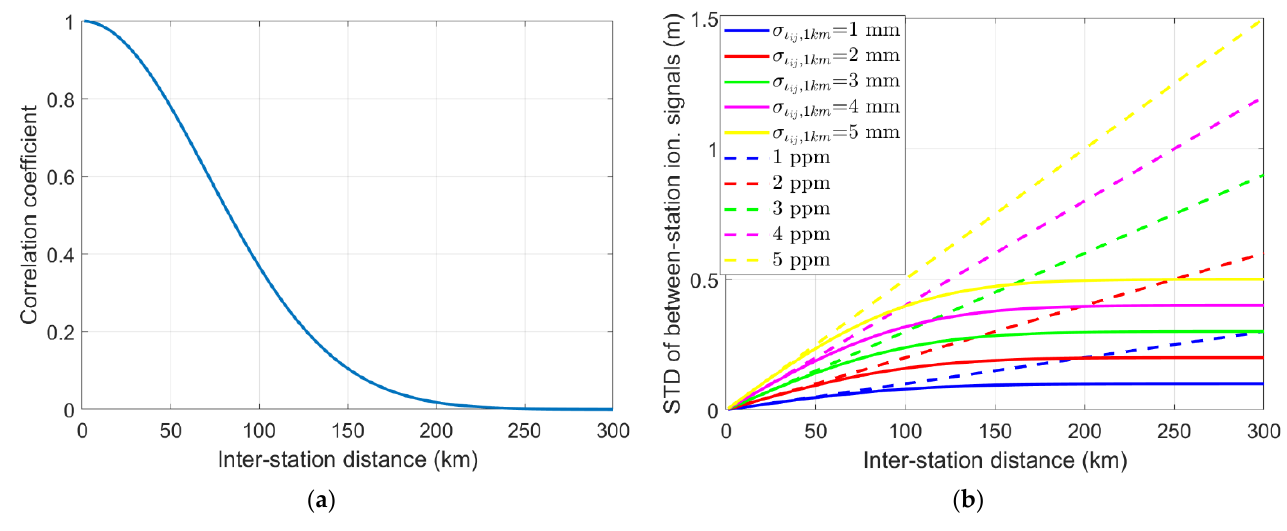
Figure 1. ( a ) Spatial correlation coefficients between the ionospheric delays and ( b ) formal standard deviations of the between-station ionospheric signals for 𝑙 (cid:2868) of 100 km.